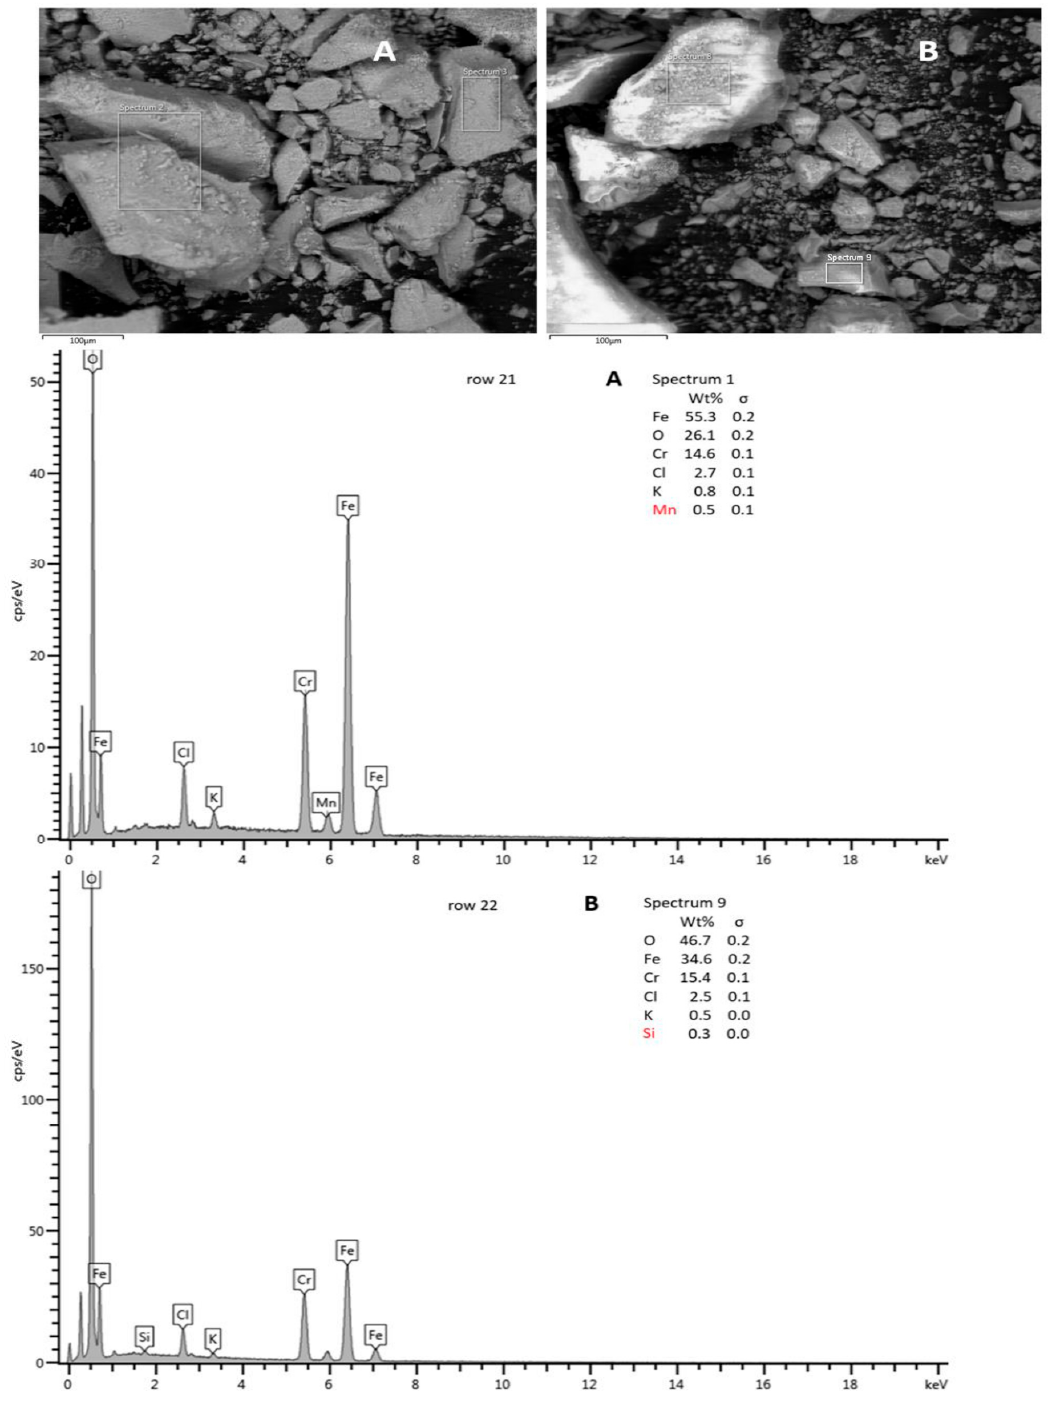
Figure 8. SEM scan and EDX analysis of solid product prepared under the conditions described in Table 1, row 21 ( A ) and SEM scan and EDX analysis of solid product prepared under the conditions described in Table 1, row 22 ( B